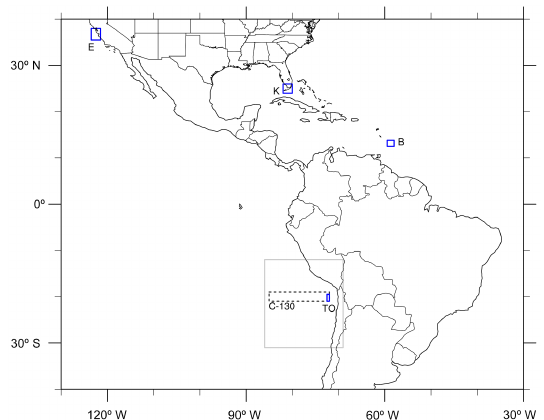
Figure 1. The geographical location of each field campaign (blue solid). E indicates E-PEACE, K indicates KWACEX, and B shows BACEX. The entire domain of VOCALS-REx is displayed as a solid grey box with domains of C-130 (dashed grey) and TO (solid blue)